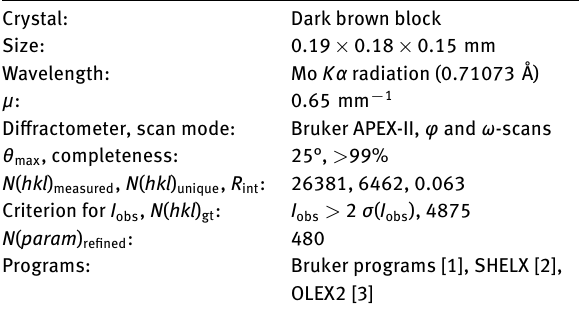
Table 1: Data collection and